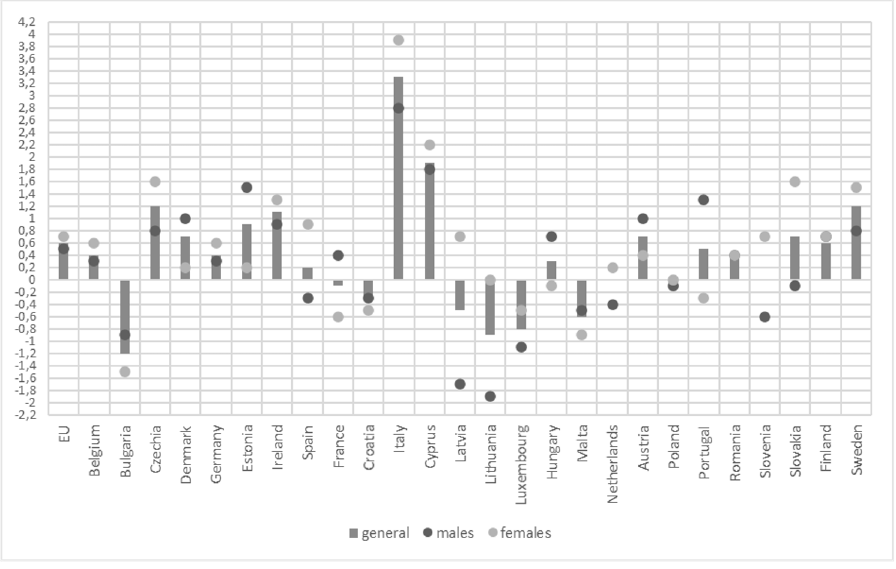
Figure 4. Change in unemployment (seasonally adjusted unemployment rates, %), April 2020 – April 2021 (pp. based on % of total employment in the group on females and males, and in general, 20–64